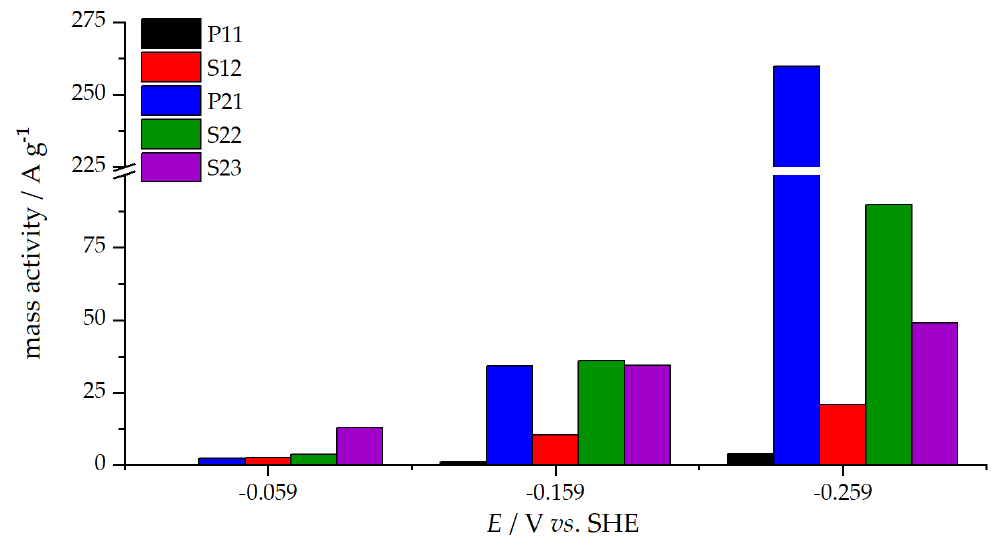
Figure 7. Mass-specific ORR activities of investigated samples at three different potentials.